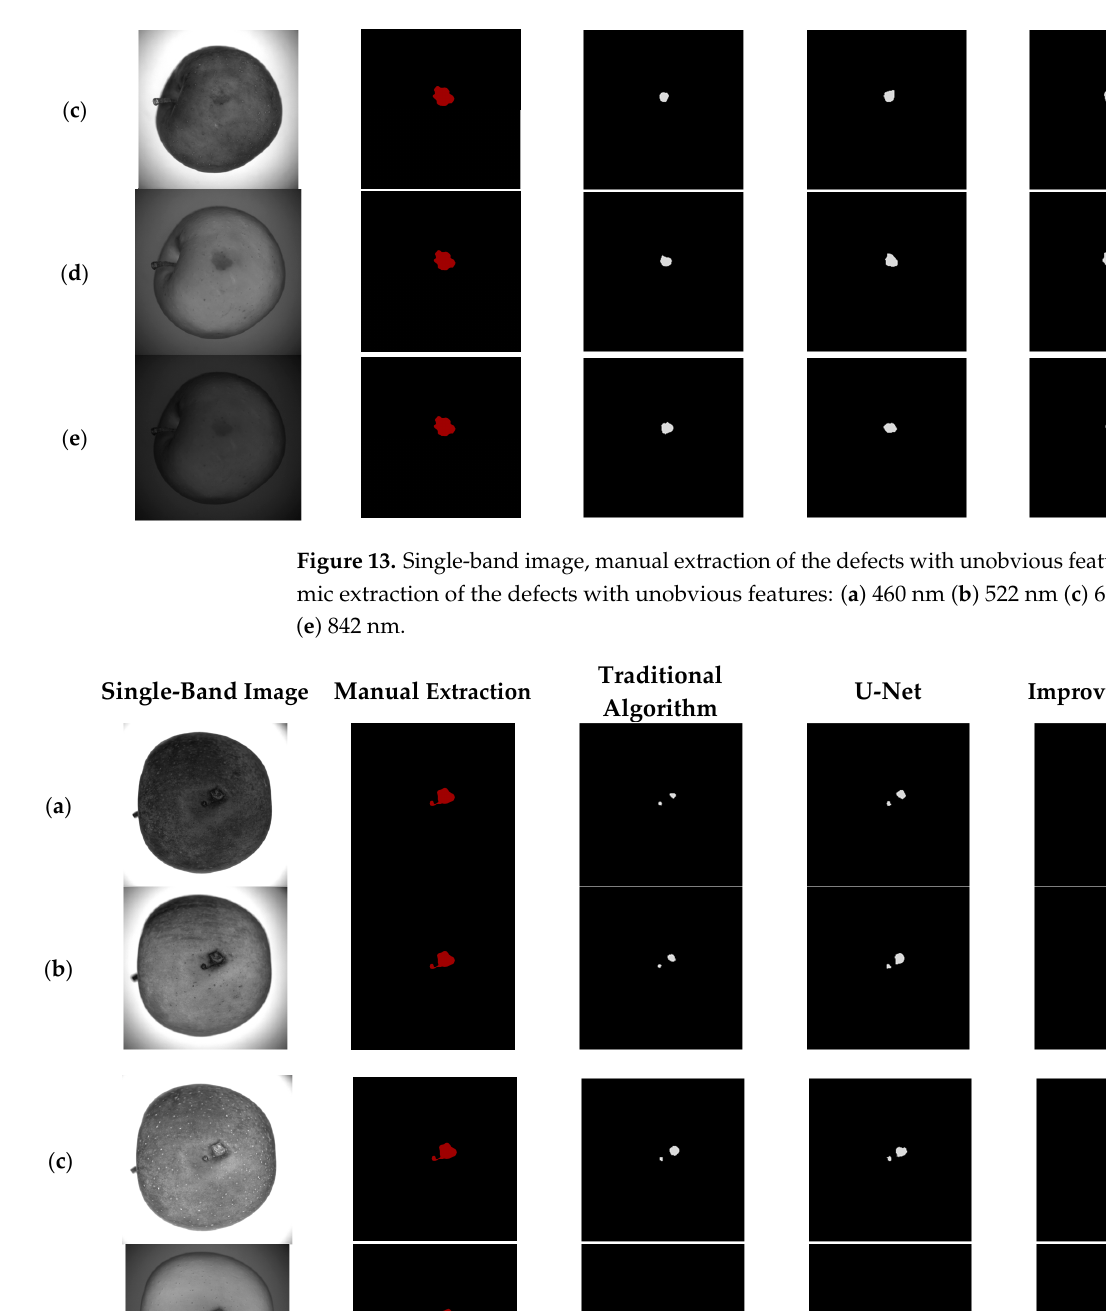
Figure 13. Single-band image, manual extraction of the defects with unobvious features, and algorithmic extraction of the defects with unobvious features: ( a ) 460 nm ( b ) 522 nm ( c ) 660 nm ( d ) 762 nm ( e ) 842 nm.